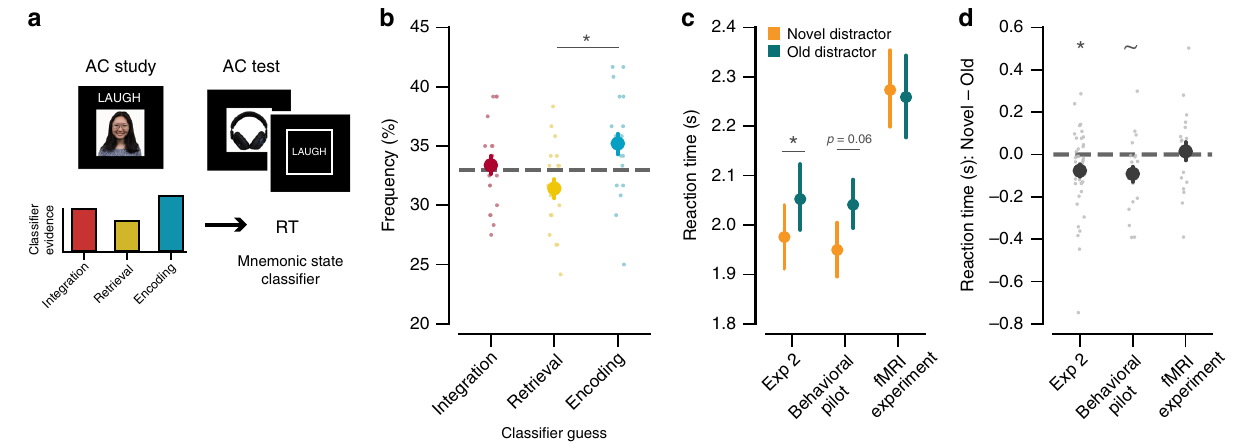
Fig. 3 fMRI study. a Data from an independent fMRI study 20 were used to train a pattern classi fi er to discriminate between three mnemonic states: encoding, retrieval, and integration. This classi fi er was then applied to (tested on) each AC Study trial. Mnemonic state evidence derived from the classi fi er during AC Study trials (depicted by the red, yellow, and blue bars) was then used to predict interference, as re fl ected in reaction times, during AC Test trials. Each dot represents data from an individual subject. b For each AC Study trial, the mnemonic state with the strongest classi fi er evidence represented the “ classi fi er guess ” for that trial. Consistent with the fact that subjects ’ instructed goal was to encode the new AC associations, the most frequent classi fi er guess was for an “ encoding state. ” c Reaction time data for AC Test trials in Experiment 2 (left), the behavioral pilot for the fMRI experiment (center), and the fMRI experiment (right). d Reaction time difference scores (Novel – Old) for AC Test trials in Experiment 2 (left), the behavioral pilot for the fMRI experiment (center), and the fMRI experiment (right). Each dot represents a difference score for an individual subject. Notes: Error bars re fl ect s.e.m.; * p < 0.05, ~ p < 0.1 by t